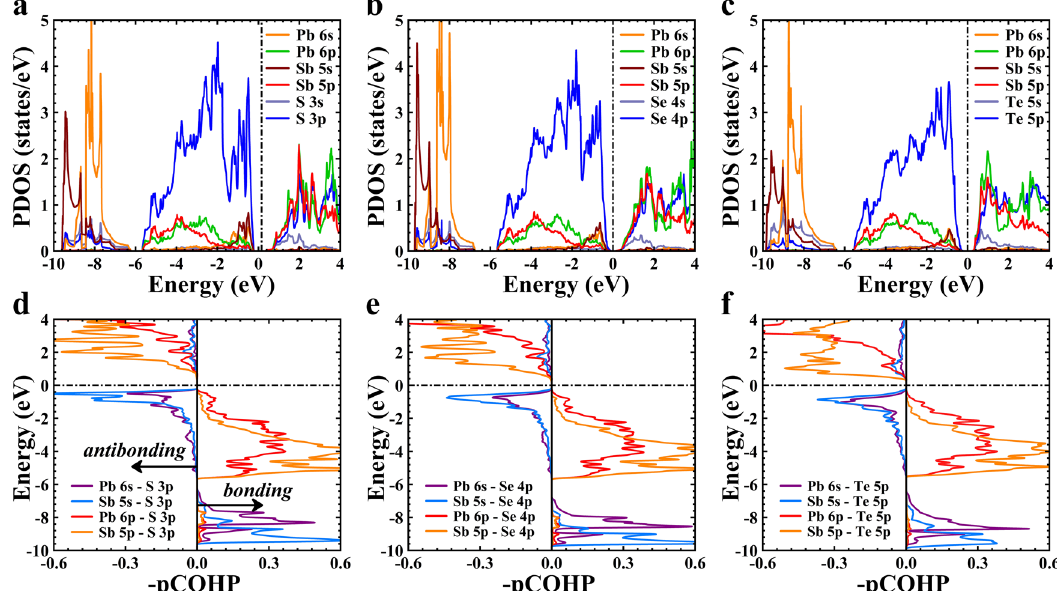
Fig. 5 Electronic density of states and pCOHP. a – c Projected DOS and d – f pCOHP of a , d Pb 2 Sb 2 S 5 , b , e Pb 2 Sb 2 Se 5 and c , f Pb 2 Sb 2 Te 5 . The Fermi energy is set to 0 eV.